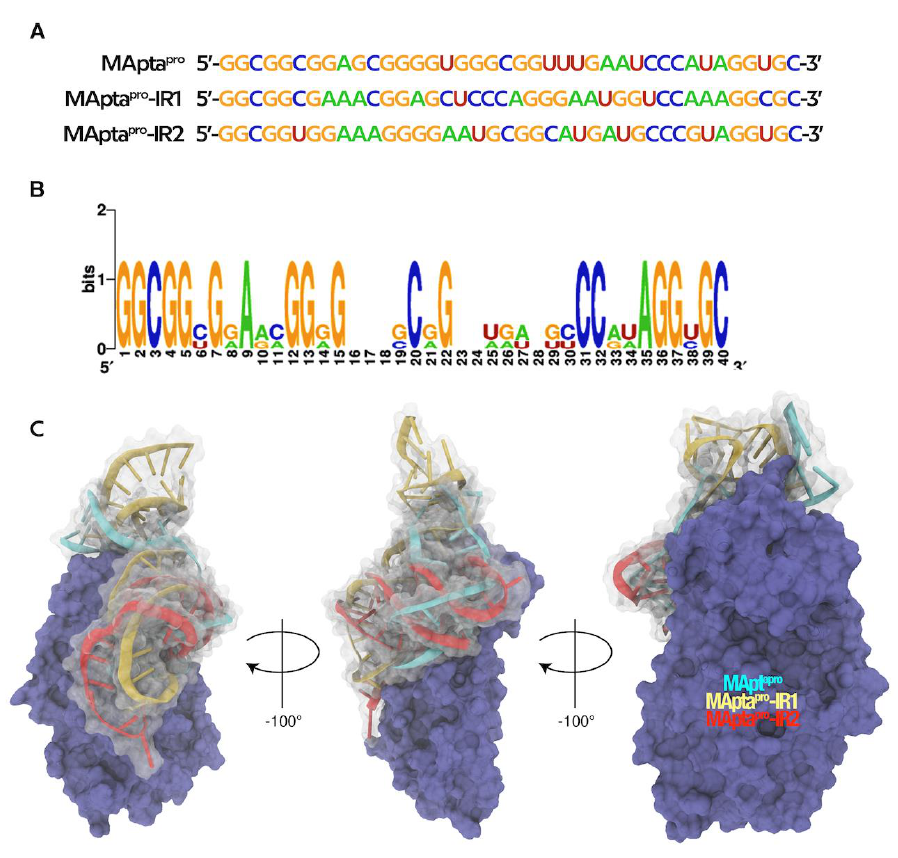
Figure 6. ( A ) Sequences of the best selected ssRNA aptamers. ( B ) Weblogo of the three sequences of the best selected aptamers. ( C ) VMD generated image showing the overlap of MApta pro (cyan), MApta pro -RI1 (yellow) and MApta pro -RI2 (red) aptamers in complex with M pro (purple).